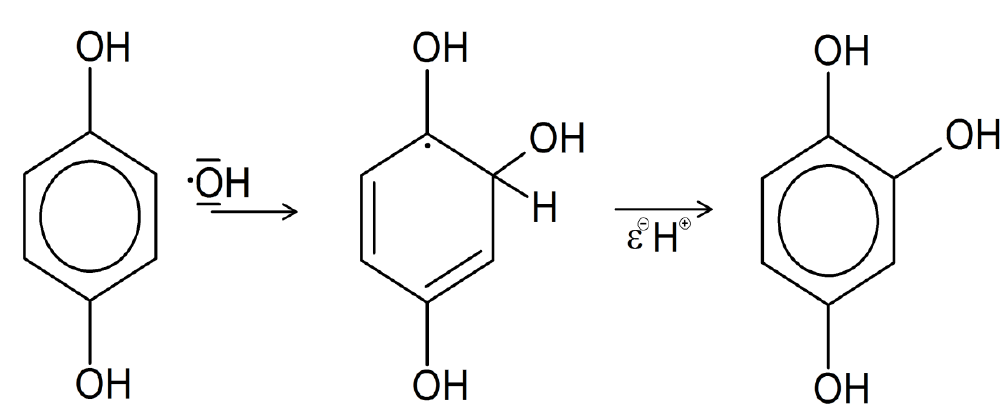
Figure 2. Introduction of a third OH- group into hydroquinone (Ziechmann, 1980, p. 149).